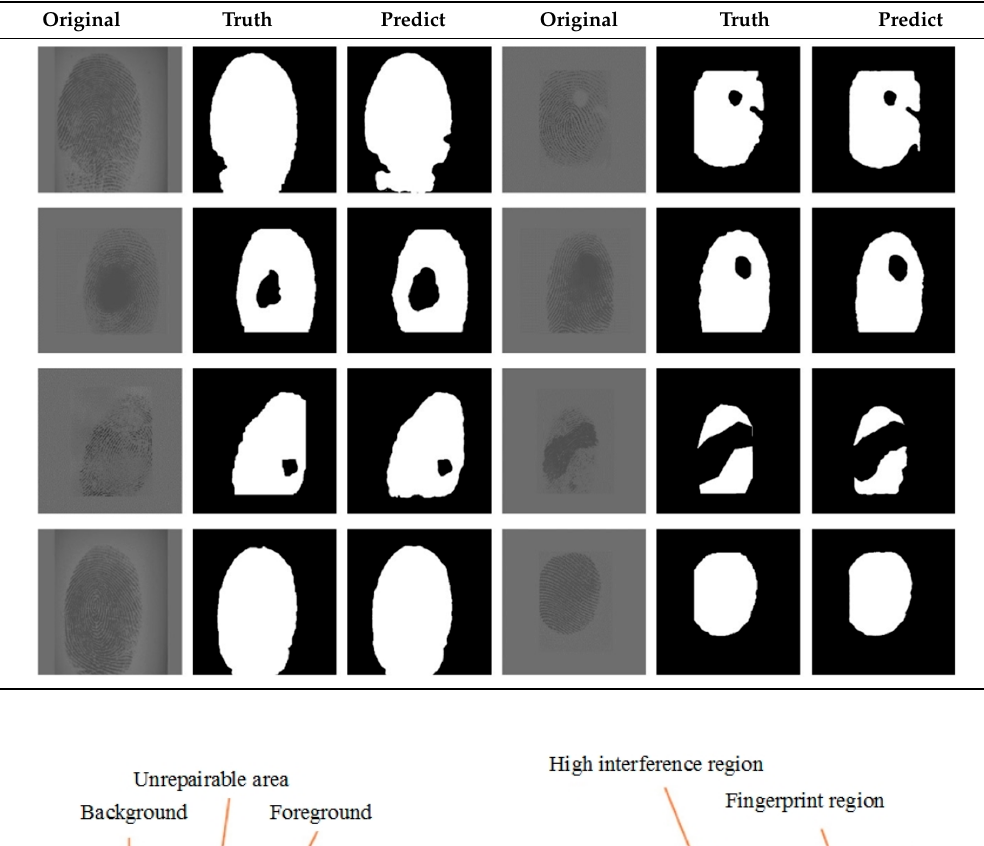
Table 4. Forward reasoning results of test set.